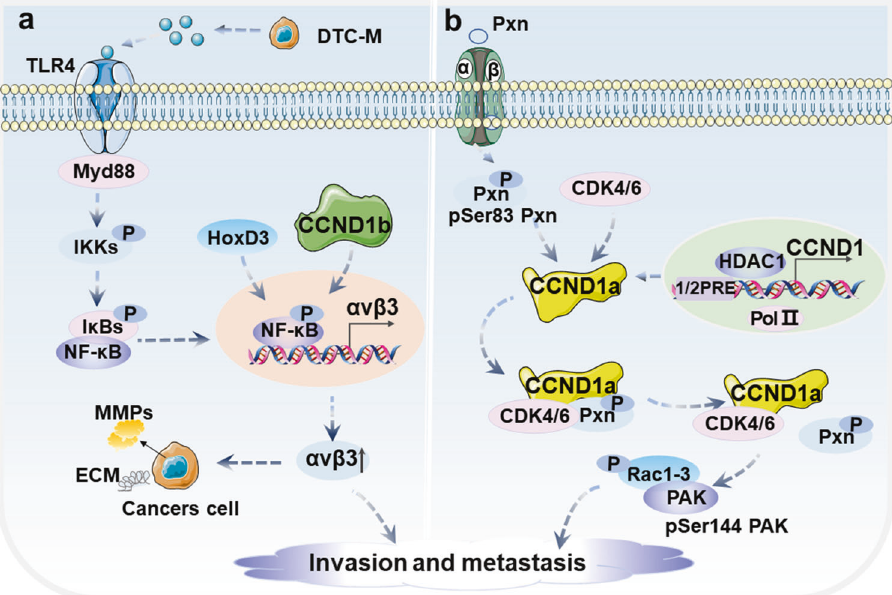
Fig. 4 Cell invasion and metastasis regulated by CCND1 isoforms. a CCND1b can synergize with HOXD3 to regulate α v β 3 expression, thus enhancing cell invasion and metastasis. b CCND1a-CDK4/6 complex promotes the activation of small GTPase RAC1 by regulating the phosphorylation of Pxn to induce cell invasion and